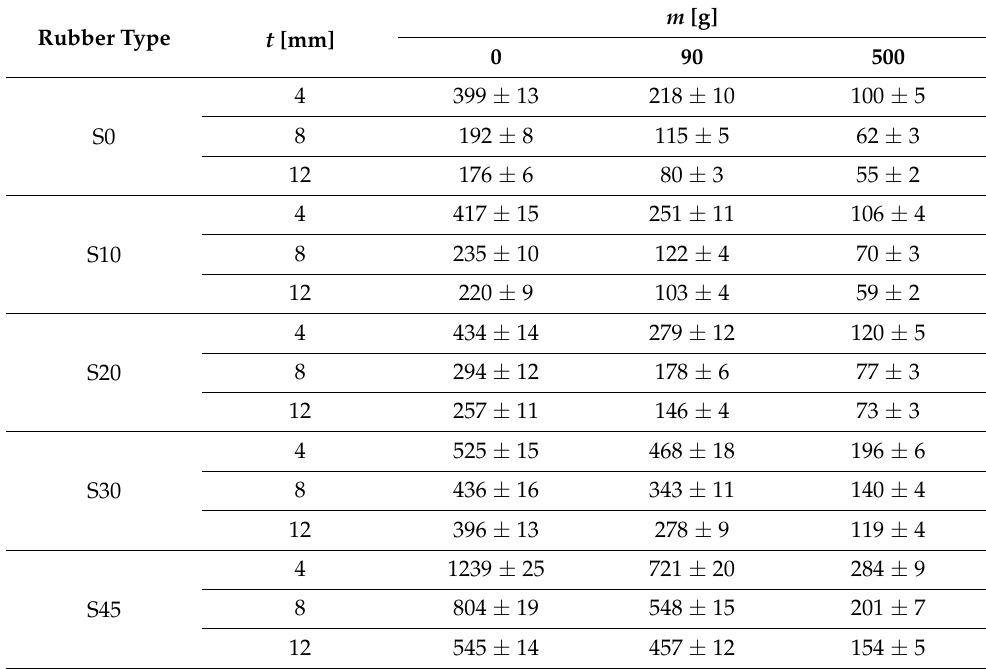
Table 4. First resonance frequency ( f R 1 ) in Hz of the studied rubber composites as induced by harmonic force vibration depending on rubber thickness ( t ) and inertial mass ( m ).